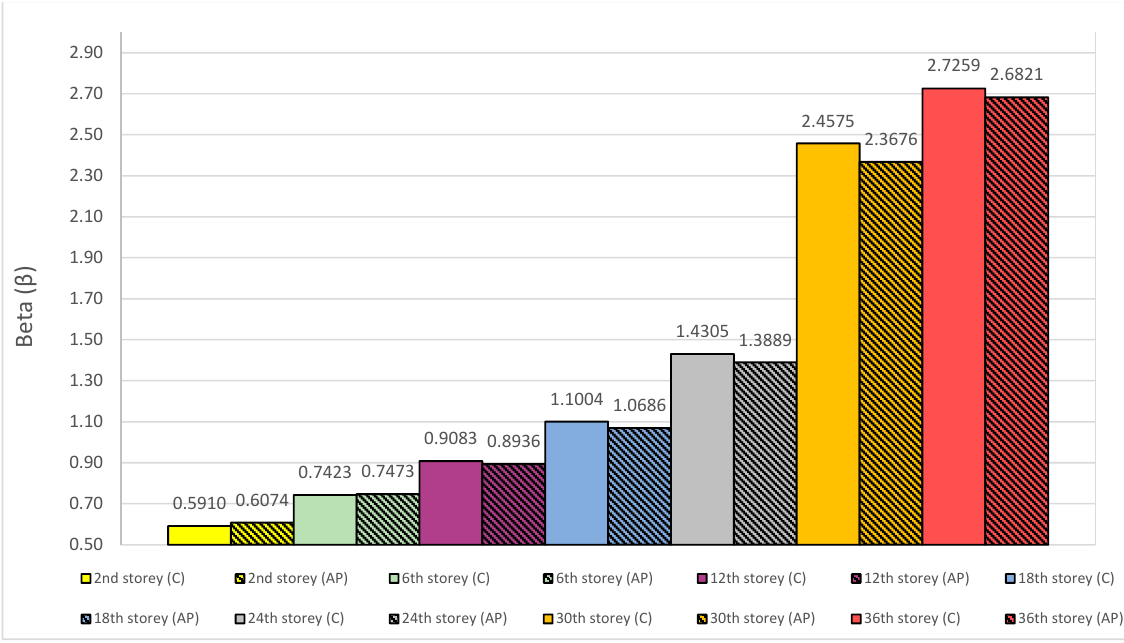
Figure 13. The change in the shear lag effect with the variation of the wind load profile (C-continuous wind load with a constant value, AP-actual wind load profile).